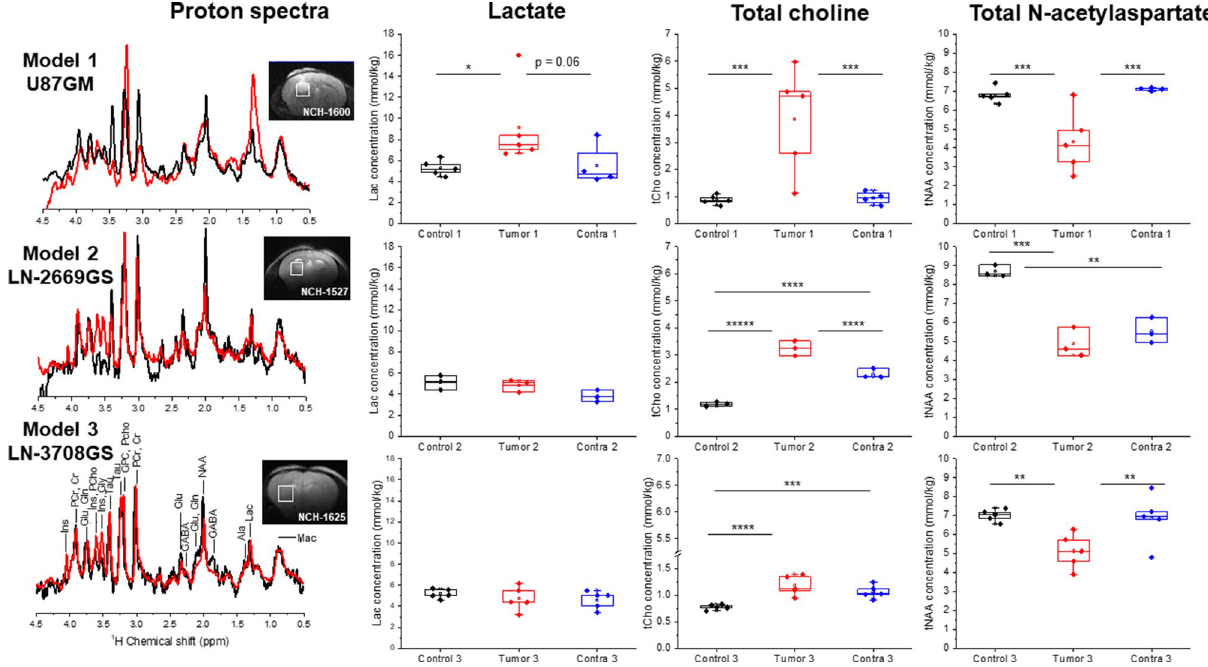
Figure 2. The steady-state concentrations of lactate, total choline (tCho) and total N -acetylaspartate (tNAA) concentrations at the day of HP glucose infusion. Localized 1 H spectra were acquired in an 8 μL voxel, located in the cell injected hemisphere, as designated by the white square in the image (red spectra), corresponding voxel in the contralateral hemisphere (not shown) and in similar voxel in control animals (black spectra). The presented concentrations are only from the animals that received the HP 13 C glucose bolus. In black are concentrations in the medium injected hemisphere in controls (control 1–3). In red, are concentrations in the tumor cell injected hemisphere (tumor 1–3), and in the blue concentrations in the contralateral hemisphere (contra 1–3) respectively, The number of ‘*’ represent statistically significant levels of p = 0.05, 0.01, 0.005, 0.001, 0.0005 and 0.00005. NCH numbers indicate the identification number of each individual